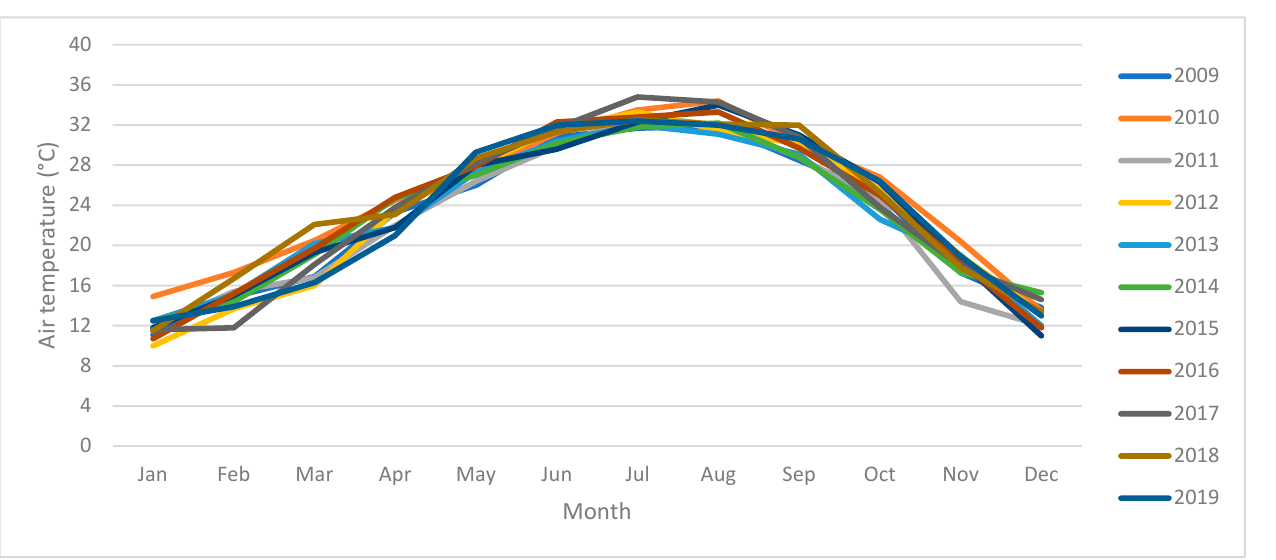
Figure 4. The daily average GHI for city of Neom between 2009 and 2019.